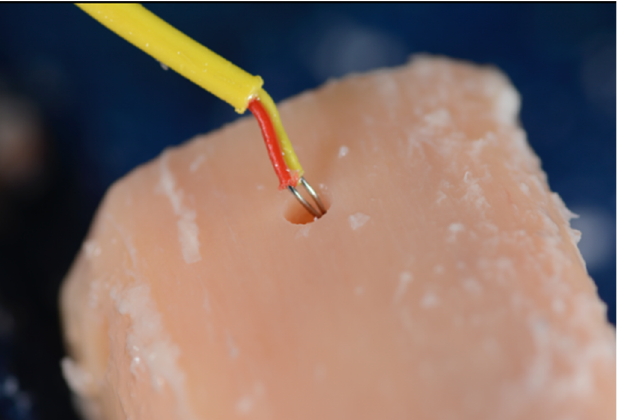
Figure 7. Each osteotomy was completed to the 6 mm depth, with external irrigation at 800, 1000, or 1200 RPM (Step 2) [24].